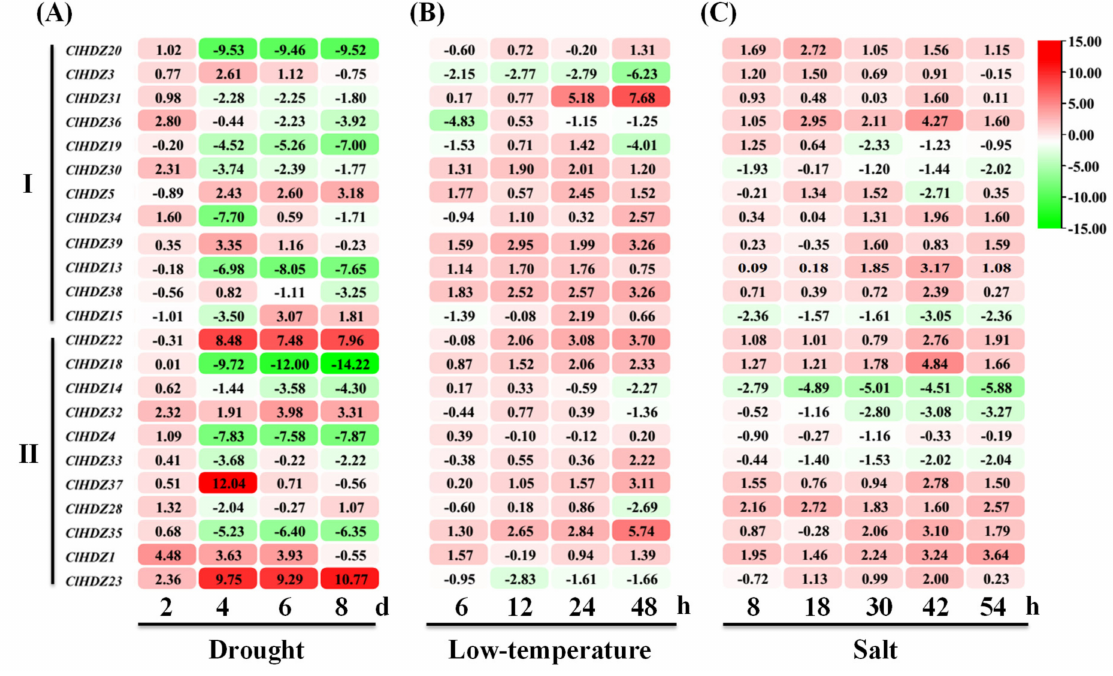
Figure 5. Gene expression heatmap of ClHDZs under drought ( A ), low-temperature ( B ), and salt ( C ) conditions. The samples at 0 dpt and 0 hpt were used as the controls, and the numbers present the relative expression levels after log2